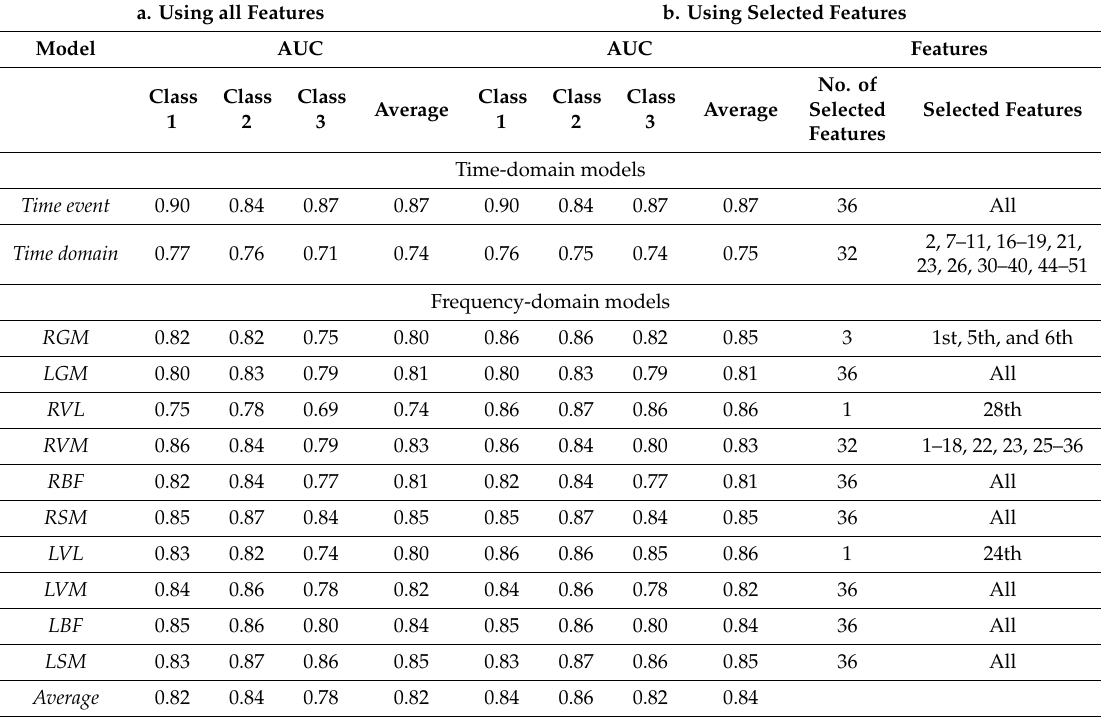
Table 3. A comparison between the classification performances based on the area under the ROC curves (AUC) using the time-event, time-domain, and frequency-based features. Classes 1, 2, and 3 represent aerobic, anaerobic, and recovery phases, respectively. ( a ) lists AUCs produced using full feature sets. ( b ) lists AUCs produced using the selected